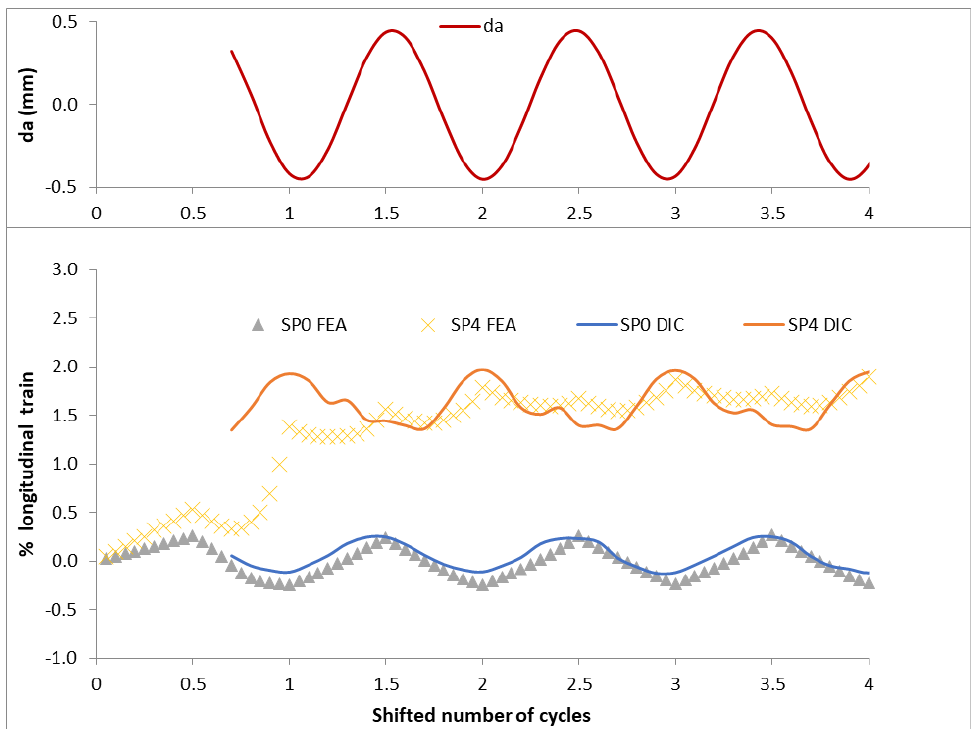
Figure 15. Surface strain at SP4 (near weld toe) and SP0; DIC (lines) vs. FEA (symbols) evaluation.